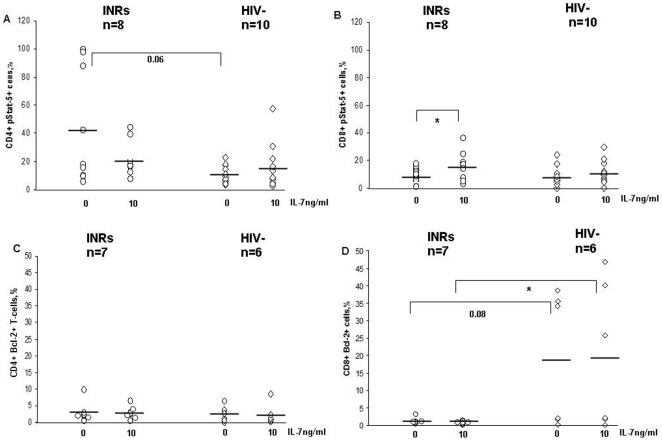
IL-7 signaling in CD4+ and CD8+ T-cell subsets.IL-7 responsiveness was analyzed by measuring the constitutive and IL-7-induced levels of phosphorylated signal transducer and activator of transcription 5 (pStat5) in CD4+ and CD8+ T cells from 8 unselected INRs compared to 10 HIV-seronegative controls (A and B). INRs displayed a trend of higher constitutive percentages of CD4+pStat5+ T cells vs. HIV-seronegative controls. Following IL-7 stimulation, the proportion of CD4+pStat5+ T cells tended to decrease in INRs (A), whereas no major changes were observed for CD8+pStat5+ T cells (B). Constitutive and IL-7-induced expression levels of the anti-apoptotic molecule Bcl-2 were comparatively measured in seven unselected INRs and six HIV-seronegative controls (C and D). No major differences in the proportions of CD4+Bcl-2+ T cells were observed between INRs and HIV-seronegative controls (C), whereas INRs displayed significantly lower proportions of constitutive and IL-7-induced CD8+Bcl-2+ T cells (D). *
P<.05.